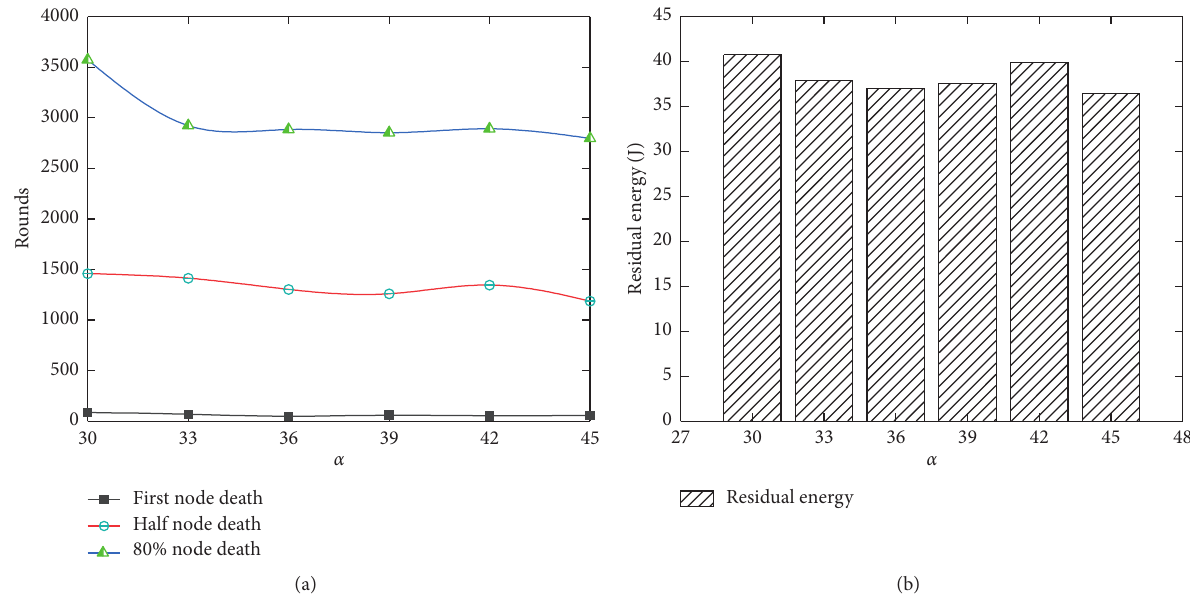
Figure 8: Affecting relations between α and assessment metrics: (a) death round with varying α and (b) residual energy with varying α